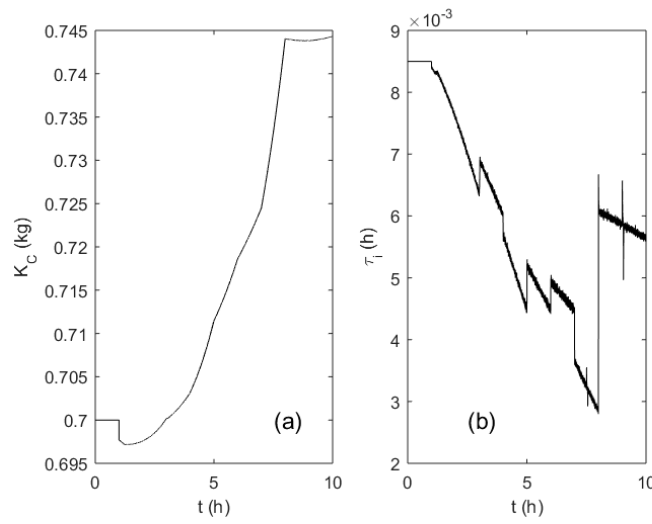
Figure 10. Evolution of the PI controller parameters K C ( a ) and τ i ( b ) during the fed-batch process.